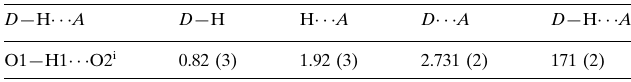
Hydrogen-bond geometry (A˚ , (cid:2)